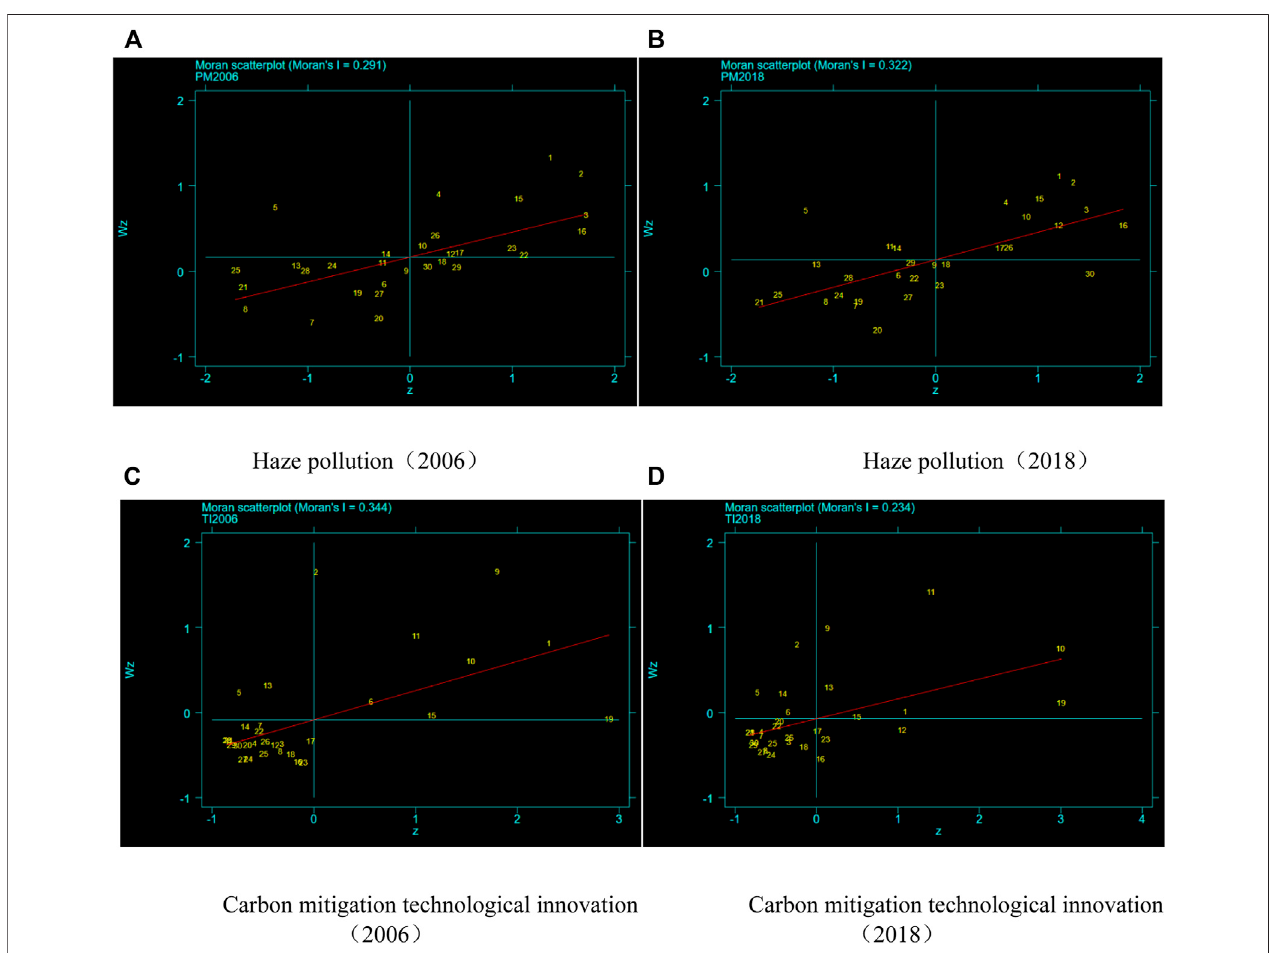
FIGURE 5 | Haze pollution and low-carbon tech-innovation local Moran ’ s I scatter diagram. (A) Haze pollution (2006). (B) Haze pollution (2018). (C) Carbon mitigation technological innovation. (D) Carbon mitigation technological innovation.